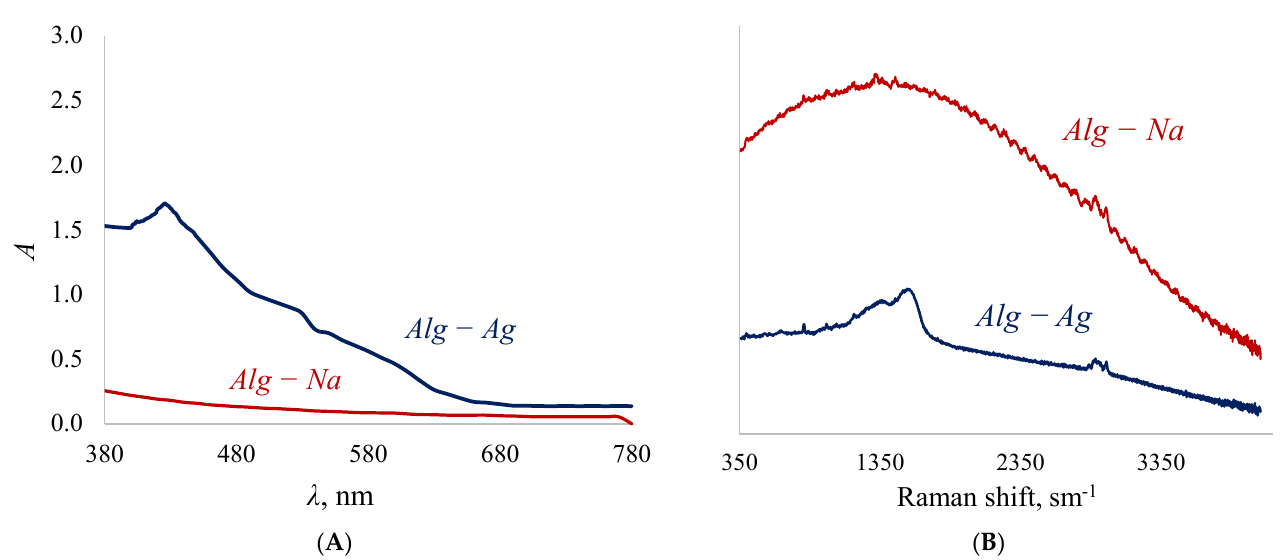
Figure 4. Visible ( A ) and Raman ( B ) spectra of sodium alginate and silver alginate. Since polysaccharides are soft reducing agents [77], there is a gradual transformation of silver cations into its atoms. The atoms, grouped with each other, form nanoparticles, which can be detected by the appearance of peaks in the visible spectrum in the region of 400–450 nm [60]. In the alginate samples obtained in this work, the peak is at 425 nm (Figure 4A), which indicates the presence of silver nanoparticles with sizes larger than 10 nm in the polymer [63]. Another piece of evidence for the formation of silver nanoparticles is the appearance of a double-humped peak (Figure 4B) in the 1500 cm − 1 region of the Raman spectrum [78]. It is known that the reduction of silver cations is always accompanied by darkening of solutions/samples, which is confirmed by the appearance of the obtained alginate films. Silver nanoparticles are clusters of atoms (Figure 5) due to which it becomes possible to introduce more silver than is possible according to the stoichiometric law.